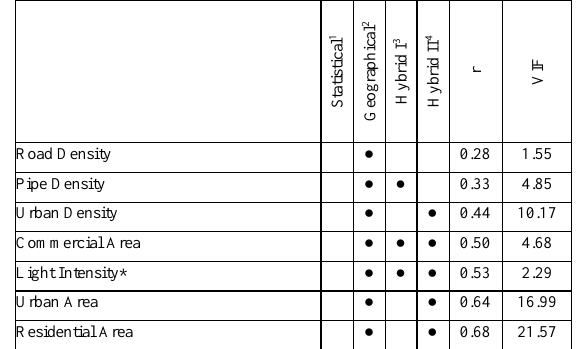
Table 2. The different four sets of predictors with Pearson’s correlation (r) and Variance Inflation Factor (VIF) values.